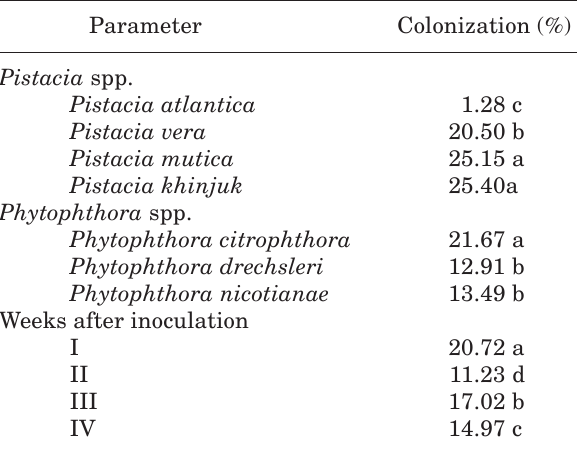
Table 1. Monitoring Phytophthora spp. as affected by host, pathogen species and time after